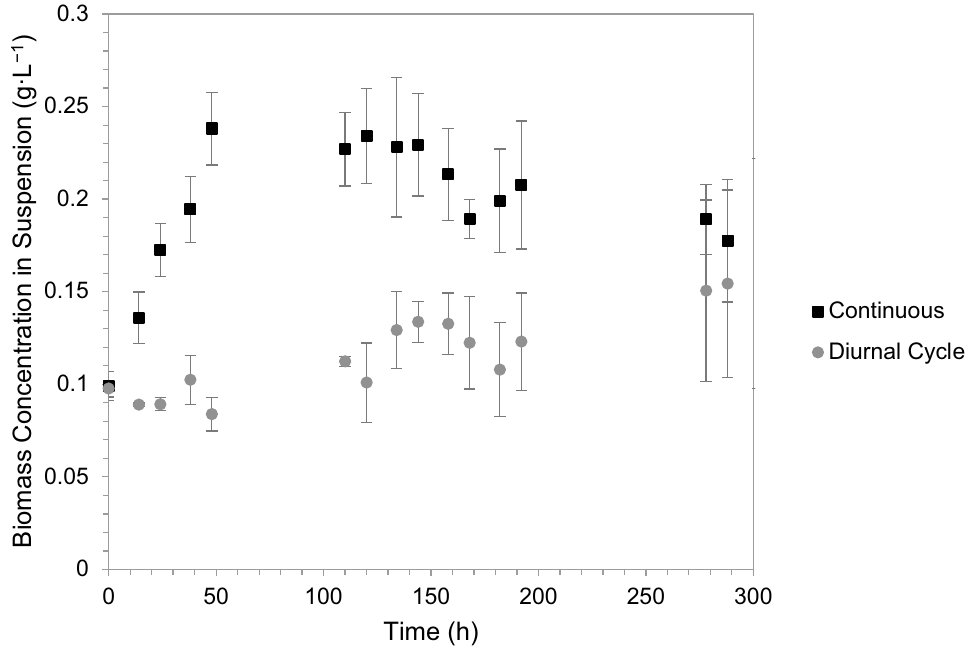
Fig. 3 Concentration of R. palustris biomass in suspension in the TPBR under continuous halogen illumination at approximately 500 W m − 2 ( W m − 2 ) and under a diurnal illumination cycle — each data point represents the mean of triplicates with the error indicated as standard